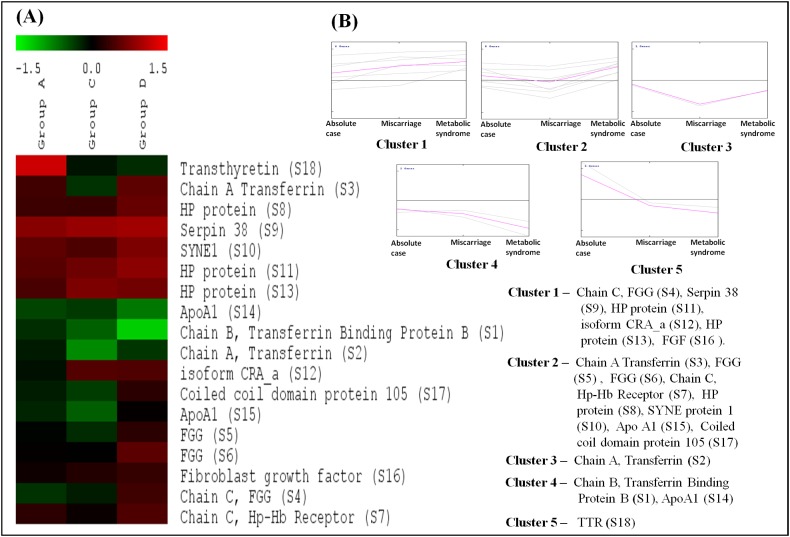
Cluster analysis based on expression patterns of the eighteen differentially expressed proteins.(A) The SOTA cluster tree illustrates differential expression of proteins in case groups. (B) The 18 differentially expressed proteins were grouped into five clusters based on their expression profiles. The mean of expression profile is marked in pink for each cluster, whereas expression profile of each individual protein in the cluster is represented by gray lines. Gr A represents absolute cases, Gr C represents metabolic syndrome, and Gr D represents the history of miscarriage.